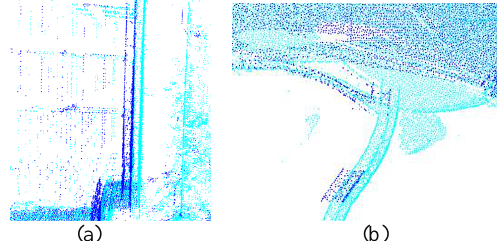
Figure 6. Registration details of Figure 5(f): (a) Building wall. (b)